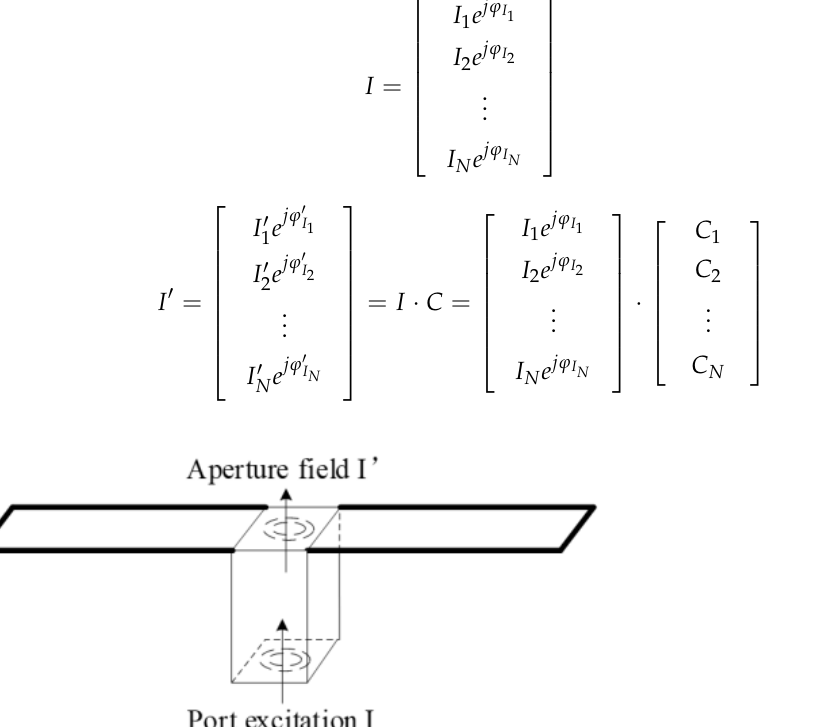
Figure 2. Schematic diagram of port excitation and aperture excitation of an element. Definition of the AEP matrix F o is shown in Equation (4), and the Equation (1) can be expressed as Equation (5), combining Equations (3) and (4). The objective is to solve the excitation coefficient matrix C of the PAA. which can be used for arbitrary beam